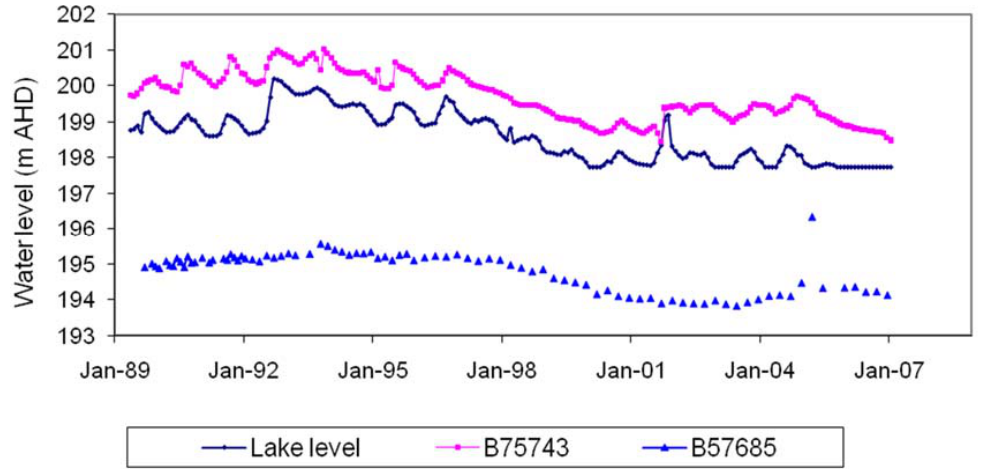
Figure 5. Comparison of bore hydrographs with the lake level. The positions of the bores are shown in Figure 4; screened depth of B57685 is from 82.5 to 88.5 m.